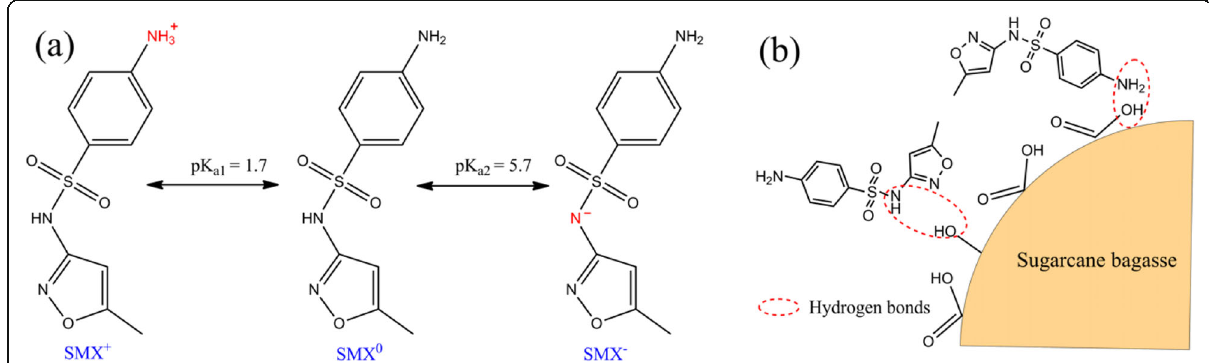
Fig. 6 Protonation and deprotonation of sulfamethoxazole molecule ( a ), and hydrogen bonding ( b